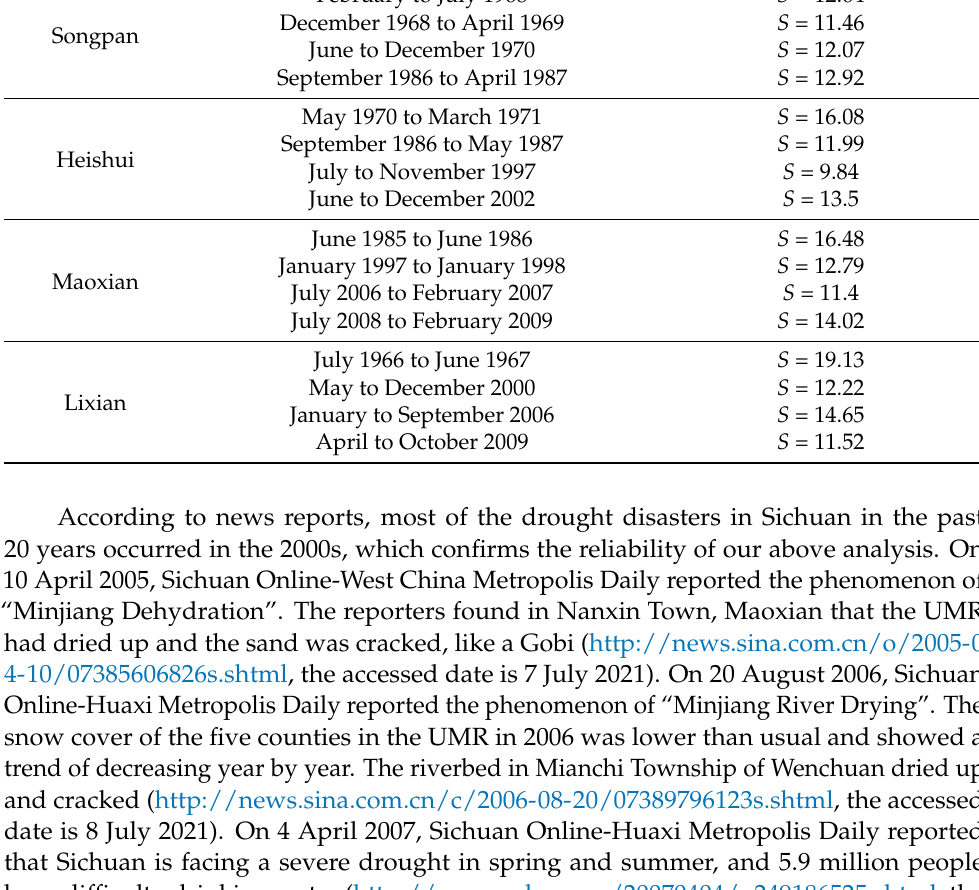
Table 3. Statistics of severe drought events in various regions from 1966 to 2016. Region The Beginning and End of the Drought Severity of Drought ( S